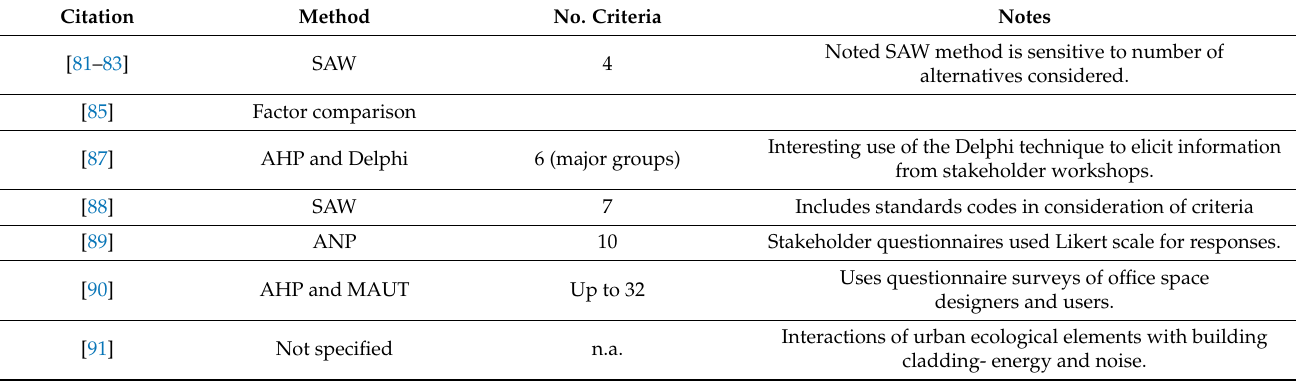
Table 8. Examples of MCDA applications in building cladding